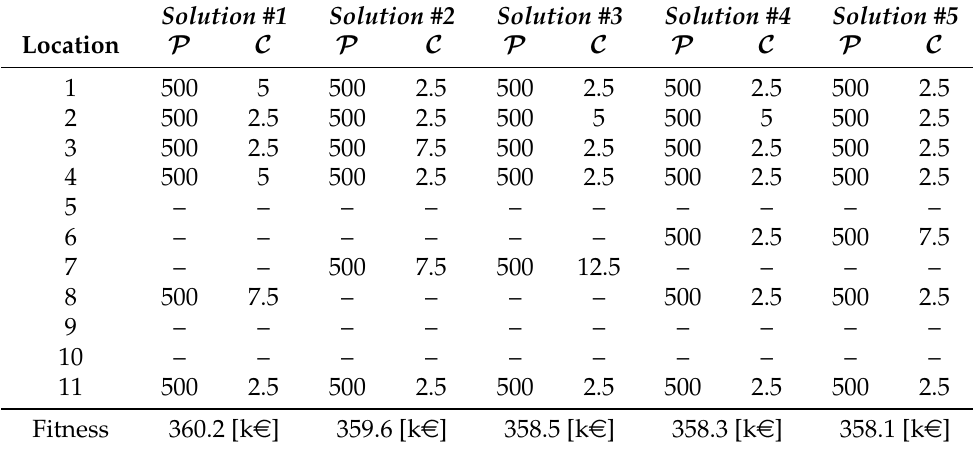
Table 3. Fitness values obtained for best solutions provided by the GA. Each solution is represented by a pair of columns, where the first refers to the power sizes ( P [kW]) and the second to the capacity sizes ( C